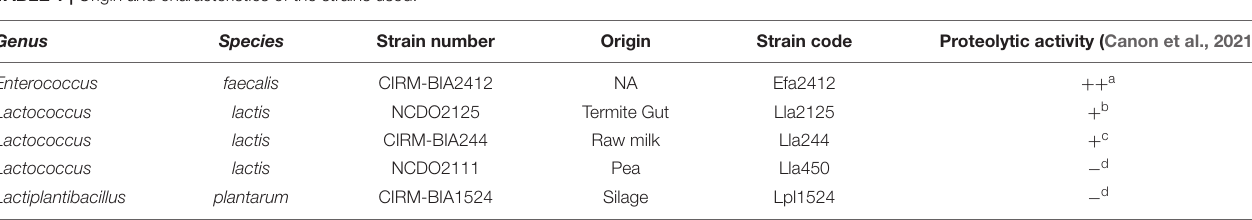
TABLE 1 | Origin and characteristics of the strains